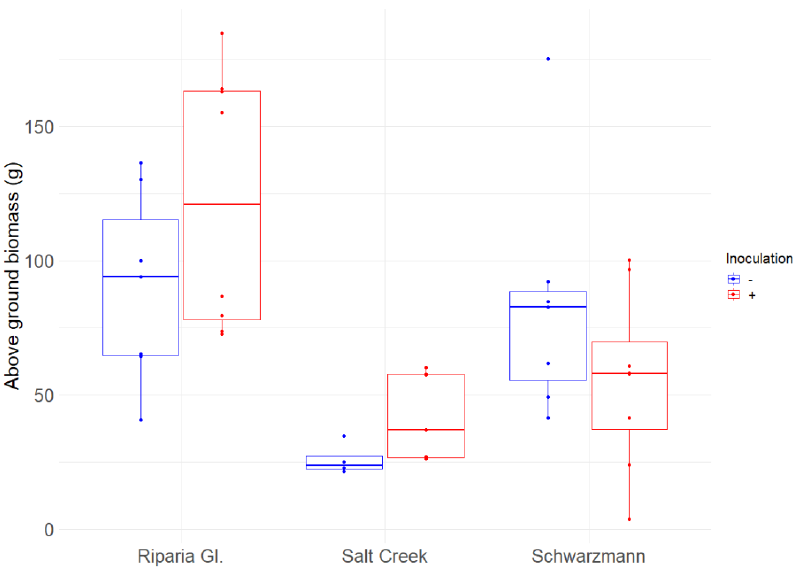
Figure 2. Above ground biomass (grams) of grapevine rootstocks after two years of field cultivation. Blue plots represent uninoculated (control) while red plots represent inoculated rootstocks. Statistical analysis was performed on the log scale.